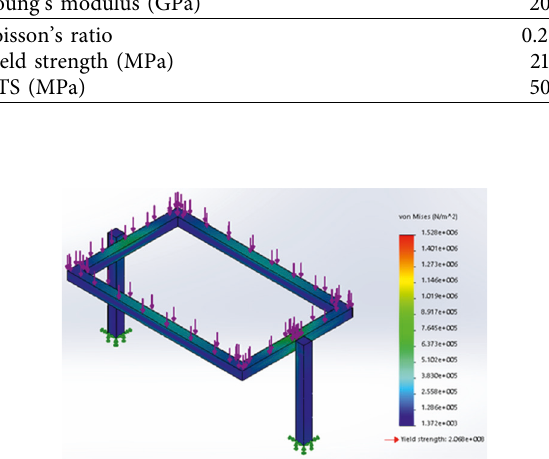
Figure 4: Stress distribution on the frame and vertical structure loaded with outer skin aircraft